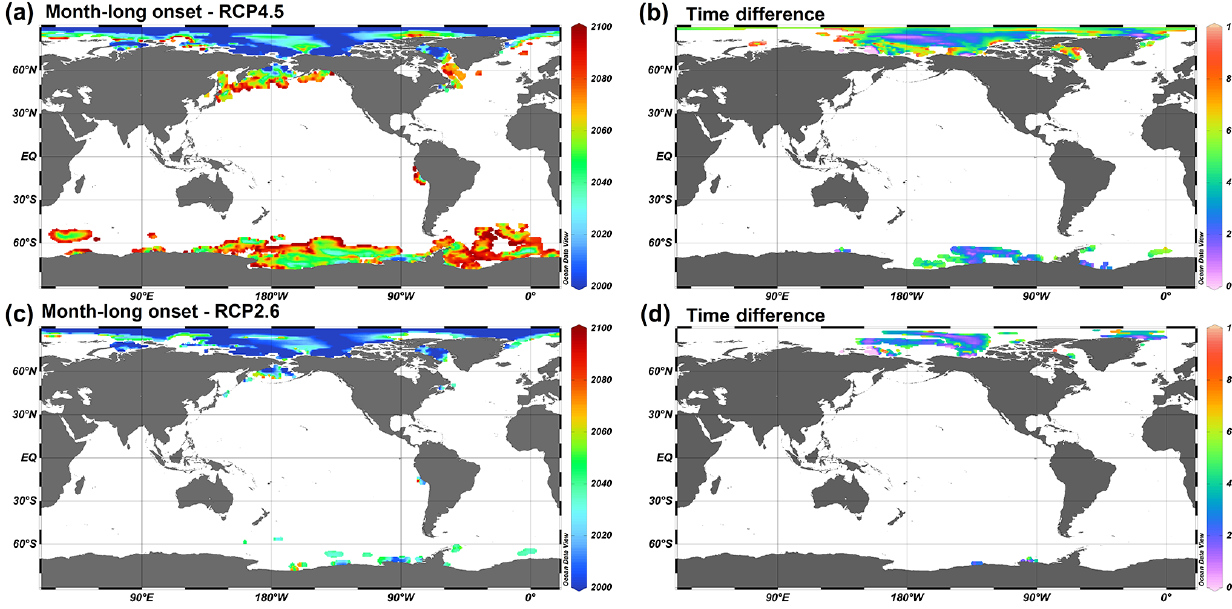
Figure 8. Onset year for month-long ocean-surface aragonite undersaturation for (a) RCP4.5 and (c) RCP2.6. Time difference (years) between month-long and annual-mean surface aragonite undersaturation onset under (b) RCP4.5 and (d) RCP2.6. Table 3. Comparison between future aragonite projections under RCP4.5 and 2.6 relative to RCP8.5. RCP Corr.